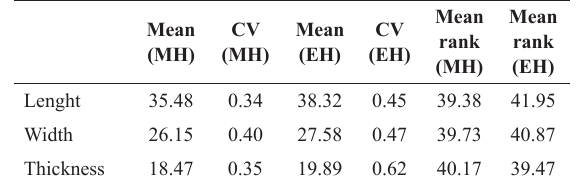
Mean, Coefficient of Variation (CV) and mean rank of flake length, width and thickness from Middle Holocene (MH, n = 243) and Early Holocene (EH, n = 91).